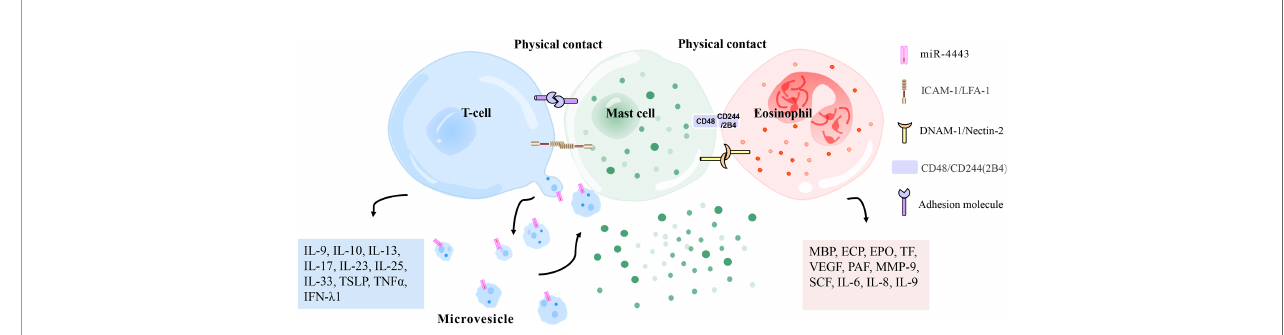
FIGURE 4 | Physical contact between mast cells and T cells/eosinophils. Mast cells and activated T cells in the in fl ammation site can perform physical contact (heterotypic adhesion) mediated by adhesion molecules (i. e. ICAM-1 [on mast cells], LFA-1 [on T cells]), thereby being activated to release in fl ammation-related mediators (histamine, TNF a , MMP-9, interleukin, metallopeptidase inhibitor 1, etc.). Heterotypic adhesion also shows that mast cells have a broad ability to directly mediate T cell activation. In addition, mast cells can be activated by microvesicles released by T cells that carry activating factors, responding to the site of in fl ammation without contact with T cells. Mast cells and eosinophils have been observed in the late and chronic stages of allergic in fl ammation to regulate each other ’ s functions by forming an effect unit. CD48 (on mast cells) and CD244 (on eosinophils), DNAM-1 (on mast cells), and Nectin-2 (on eosinophils) have been reported to mediate this effect. ECP, eosinophil cationic protein; PAF, platelet-activating factor; MMP-9, matrix metalloproteinase-9; IFN- l 1, interferon- l 1; EPO, eosinophil peroxidase; MBP, major basic protein; VEGF, vascular endothelial growth factor; SCF, stem cell factor; TSLP, thymic stromal lymphopoietin; TNF a , tumor necrosis factor a ; TF, tissue factor; ICAM-1, intercellular adhesion molecule-1; LFA-1, leukocyte function-related antigen-1; DNAM-1, DNAX accessory molecule